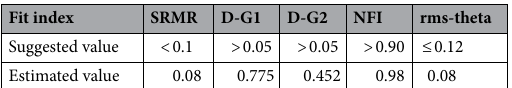
Table 6. Summary of Goodness of Fit Indices for the Measurement